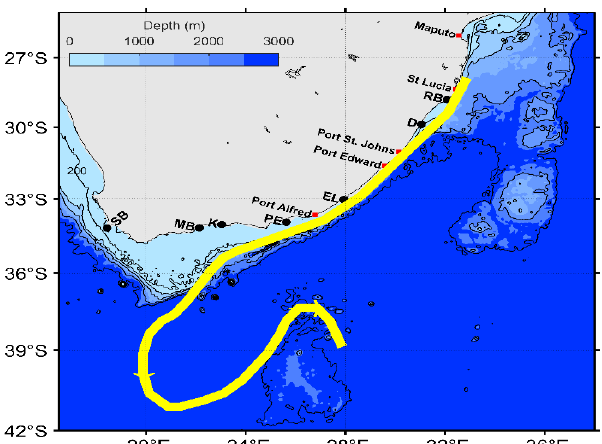
Figure 1. The location of tide gauge stations used in this study. RB, D, EL, PE, K, MB and SB indicate Richards Bay, Durban, East London, Port Elizabeth, Knysna, Mossel Bay and Simon’s Bay tide gauges sites, respectively. Solid yellow line indicates the typical path of the Agulhas Current.